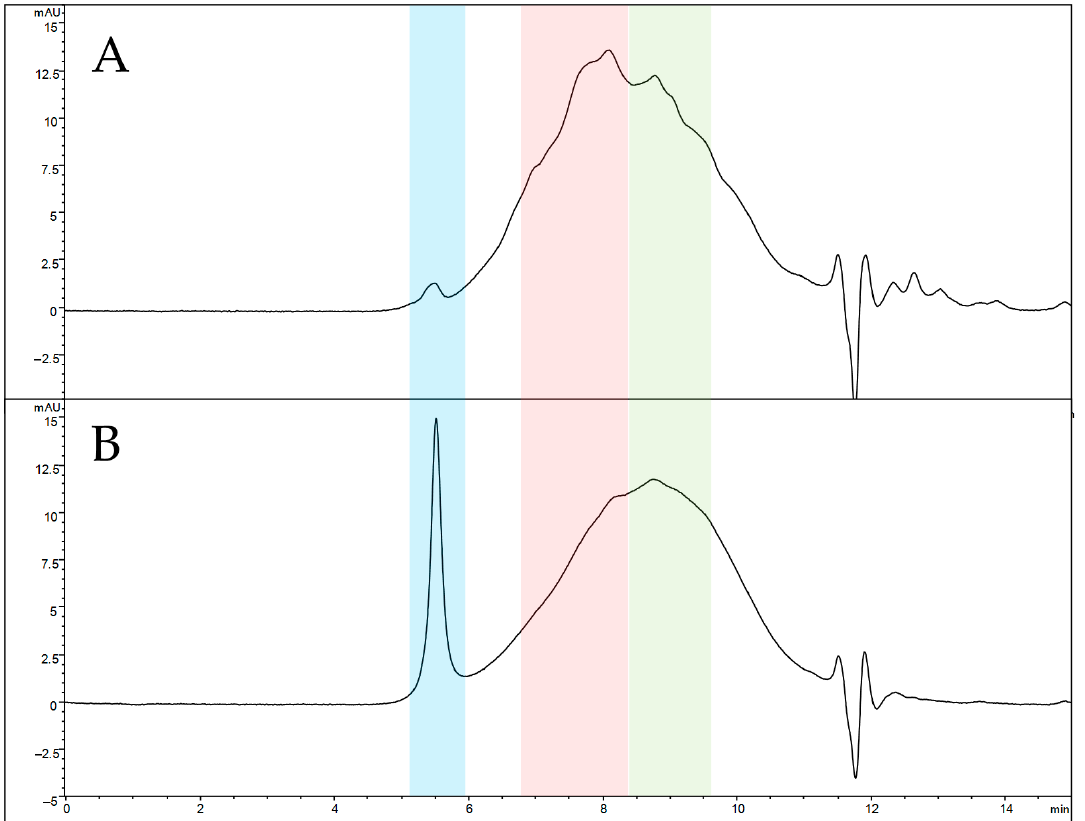
Figure 4. SEC-UV profiles of solubilized naked ( A ) and functionalized ( B ) SFNs. Elution windows of the three main protein populations are colored in blue (apex at 5.5 min, estimated MW greater than 700 kDa), red (apex at 8.1 min, estimated average MW of 110 kDa) and green (apex at 8.8 min, estimated average MW of 66 kDa).